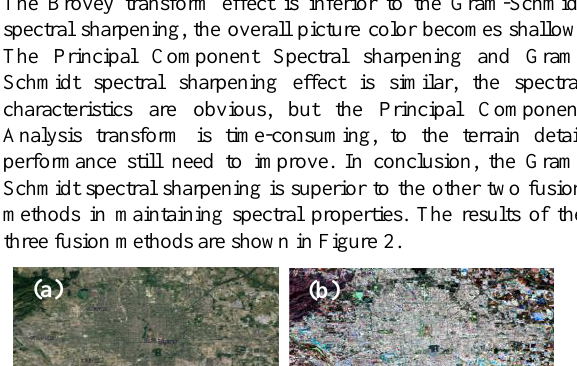
Figure 4. The results of the four classification methods. (a) Minimum distance; (b) Mahalanobis distance method; (c) Support Vector Machines; (d) ISODATA